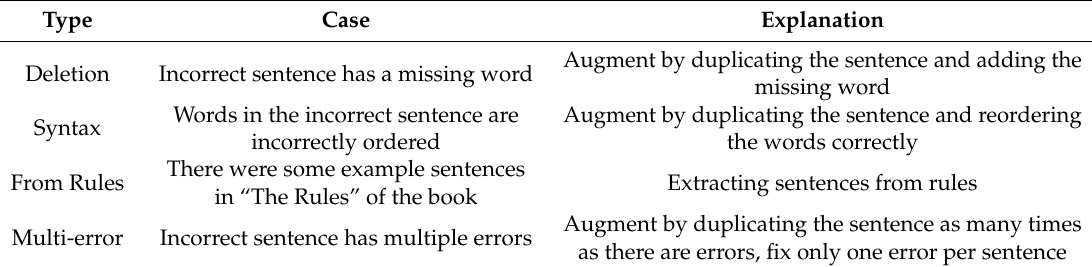
Table 3. Types of